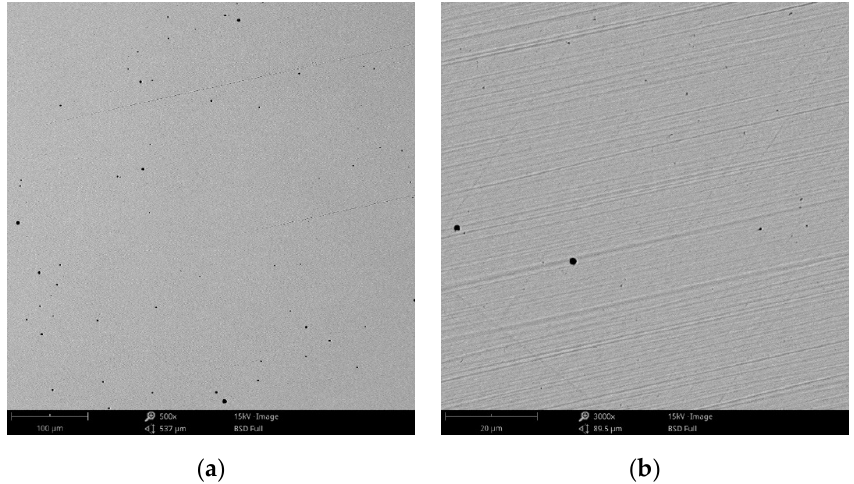
Figure 3. SEM images of the CCm (milled Co-Cr alloy) sample surface at: ( a ) 500×; ( b ) 3000×.